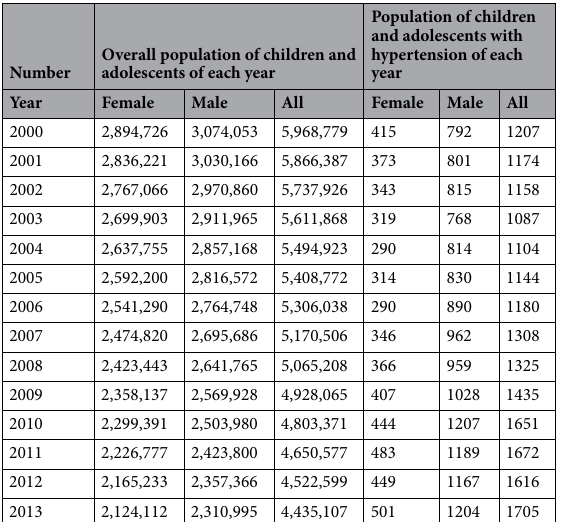
Table 1. The population of overall children and adolescents and of those with hypertension in each year from 2000 to